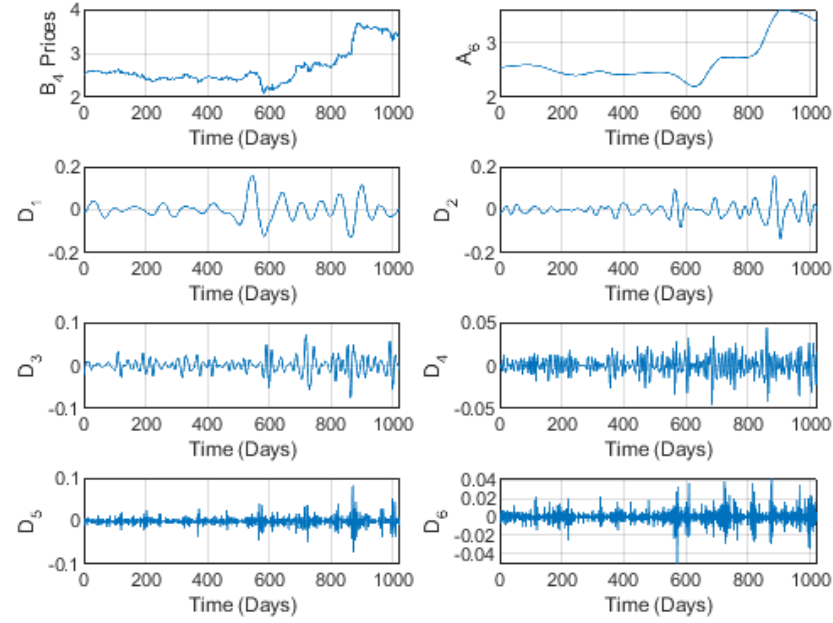
Figure 7. The wavelet decomposition of the Al Abdullatif brand B 4 prices at level 6.